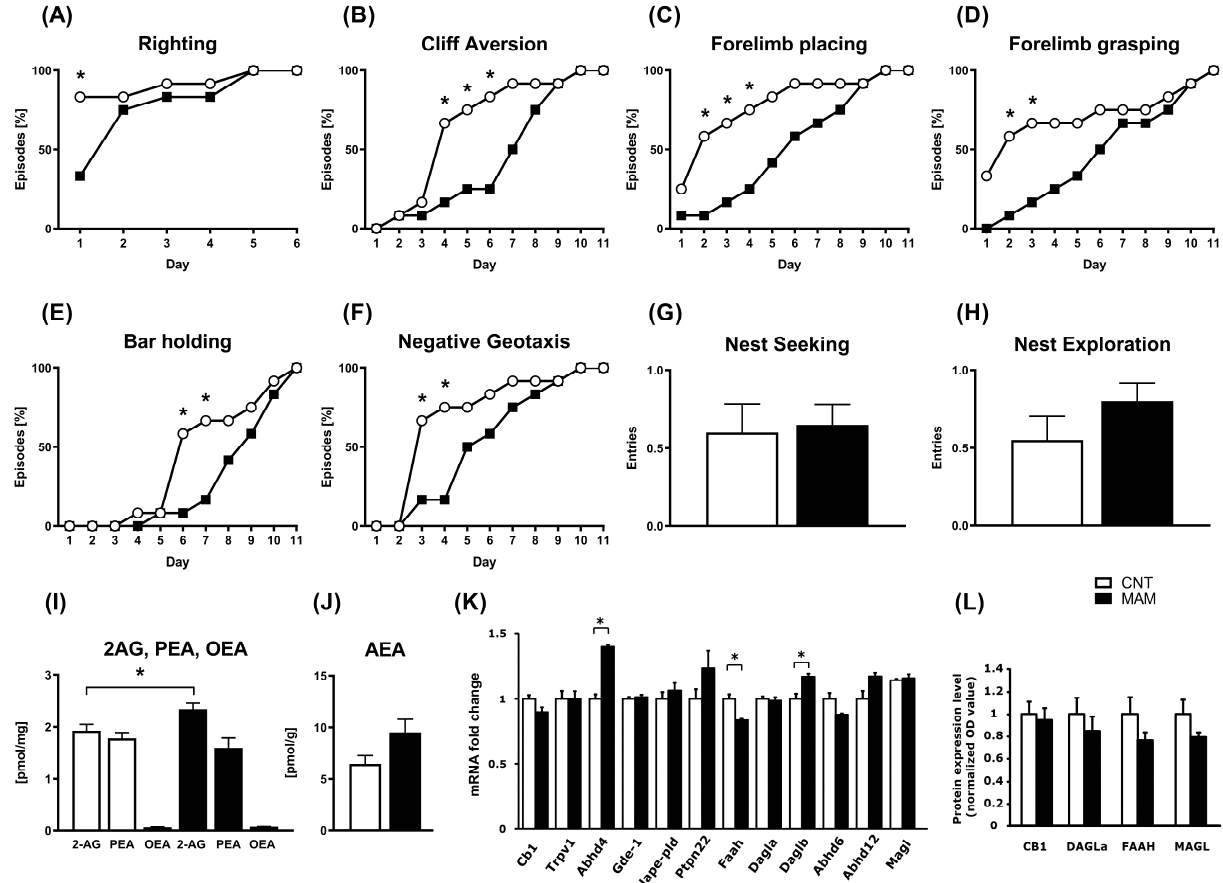
Figure 2. Effects of prenatal MAM exposure on neonatal behavior and endocannabinoid system (ECS) elements in rat pups. Data are presented as the mean values ± S.E.M.: ( A – F ) percentual cumulative appearance of each reflex on each day, per group of animals ( n = 20), ( G ) the number of approaches towards maternal nest (nest seeking) and ( H ) nest exploration ( n = 20/group), ( I ) 2-AG, PEA, OEA and ( J ) AEA levels, of ( K ) gene and ( L ) protein expression of ECS elements (receptors and metabolic enzymes; n = 3–5/group). * p < 0.05 vs. CNT.